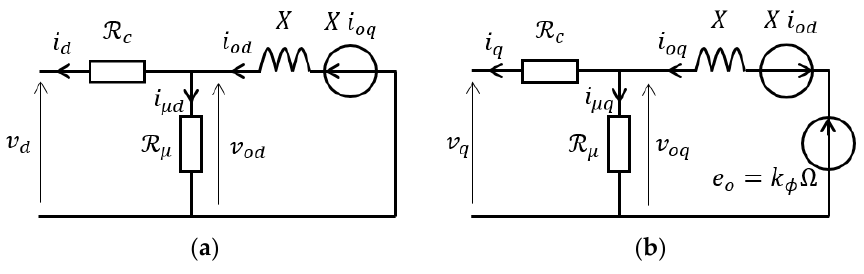
Figure 1. ( a ) d-axis equivalent circuit; ( b ) q-axis equivalent circuit.